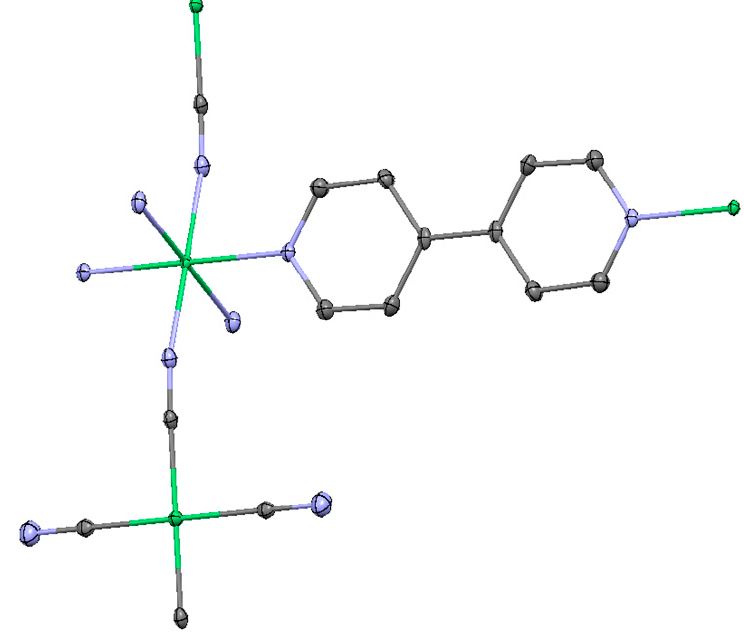
Figure 16. The basic motif of the Ni(Bpy)[Ni(CN) 4 ] molecules (C-grey, N-blue, Ni-green; probability ellipsoids drawn at